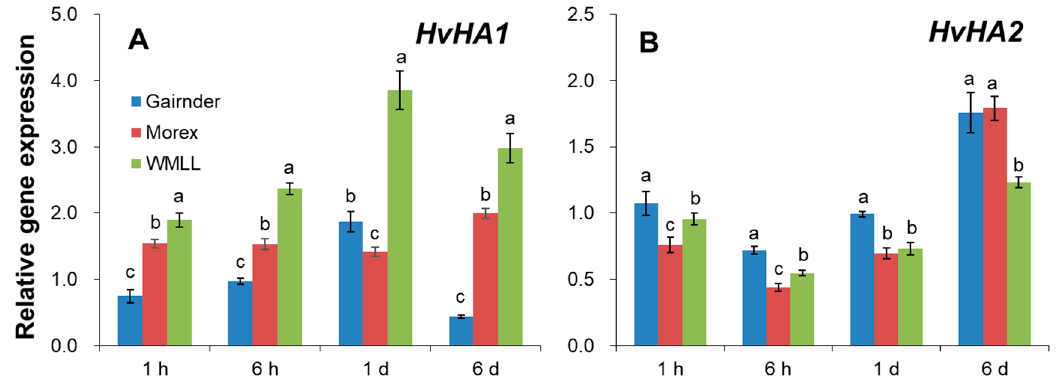
Figure 9. Transcript levels of plasma membrane H + -ATPase genes HvHA1 ( A ) and HvHA2 ( B ) in barley roots after onset of drought stress generated by 20% PEG8000. Gene expression under control condition at each period was normalized to 1, and gene expression under drought condition at every sampling time was compared relative to it respectively. Vertical bars represent means ± SE of three biological replicates. Di ff erent lowercase letters indicate the significant di ff erence between genotypes at p <